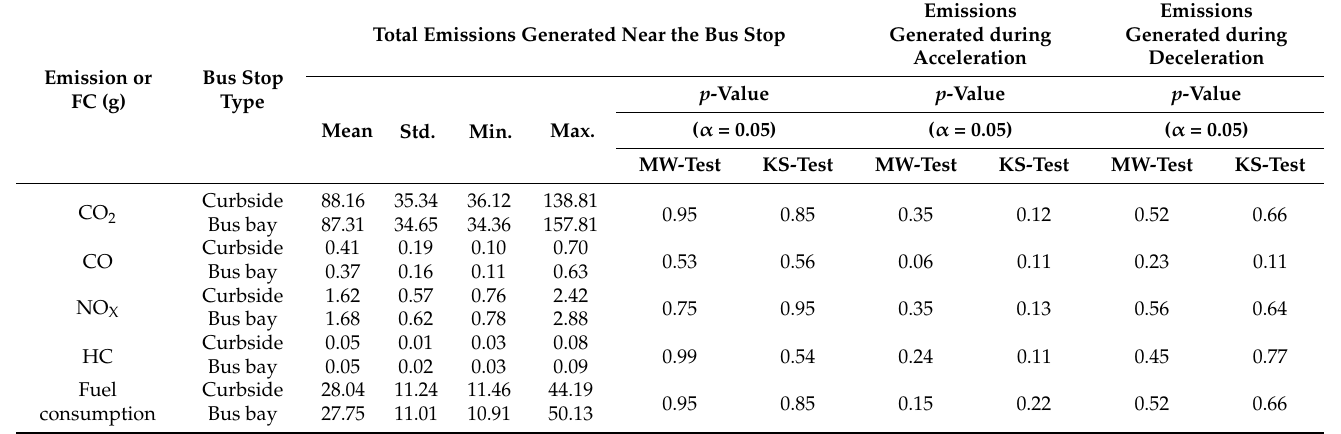
Table 6. Non-parametric test results for bus emissions and FC at the two types of bus stops.